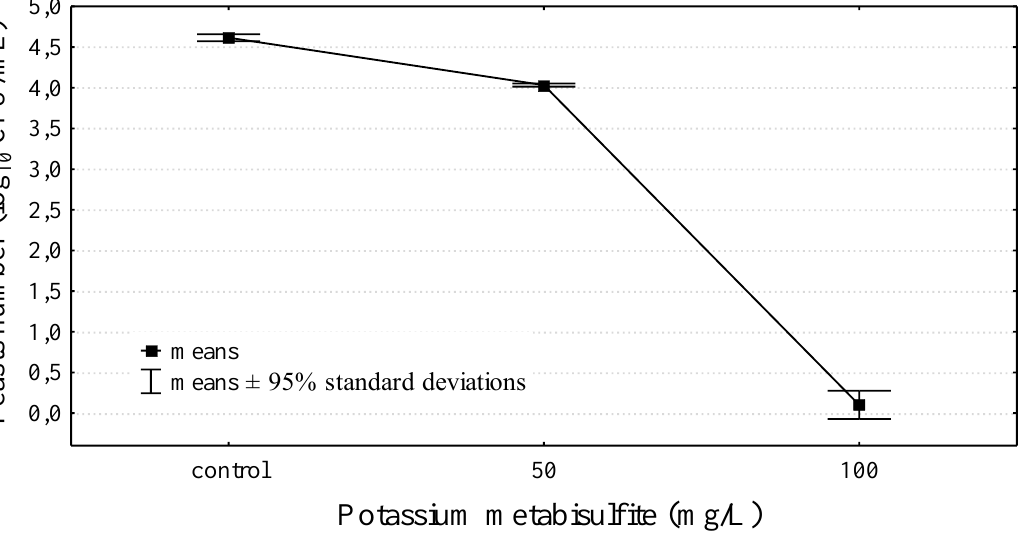
Figure 1. The influence of potassium metabisulfite on yeasts survival in wine fermented for 15